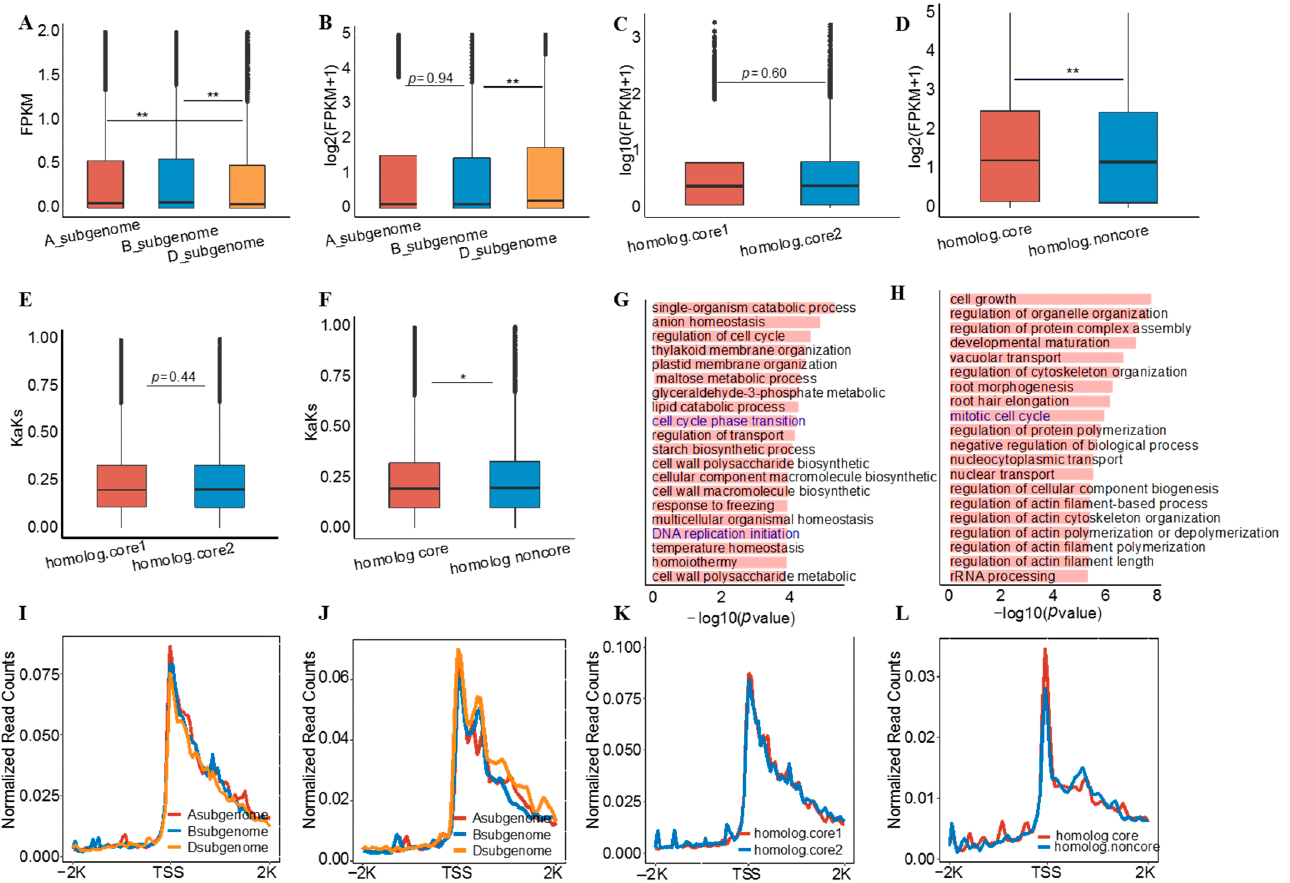
Figure 2. Core and non-core genes have different roles in subgenome differentiation. ( A , B ), ( A ) Comparing the expression levels of all core genes and ( B ) all non-core genes within subgenomes. ( C-F ), Comparisons of expression levels and KaKs values between paired homologous genes. where ( C , E ) indicate that both genes are core genes, and ( D , F ) indicate that one gene is a core gene, and another is non-core genes. ( G,H ), GO enrichment analyses of core and non-core genes in homologous gene pairs, ( G ) indicates GO terms specific to the core genes; ( H ) indicates GO terms specific to the non-core genes. Only the top 20 most important GO terms are listed. ( I-L ), GRO-seq read the intensity of all core genes ( I ), all non-core genes ( J ), all homologous pairs as core genes ( K ), and only one homologous pair as core gene ( L ). In general, GRO-seq signals and gene expression levels were positively correlated. Where * indicates that p < 0.05, ** means p < 0.01.